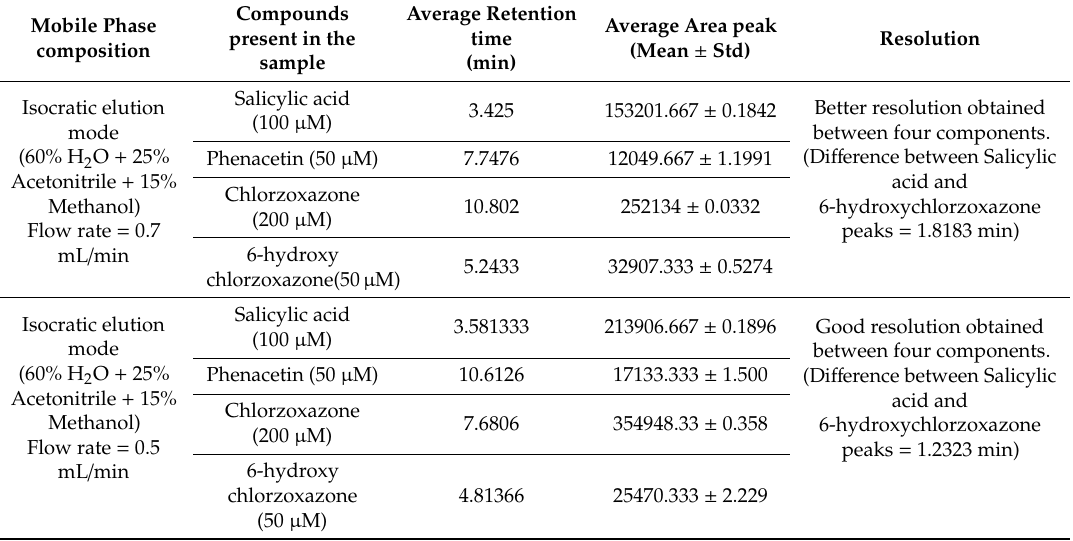
Table A4. Variation in retention time, and area peak between compounds when changing the flow rate. Compounds Mobile Phase present in composition